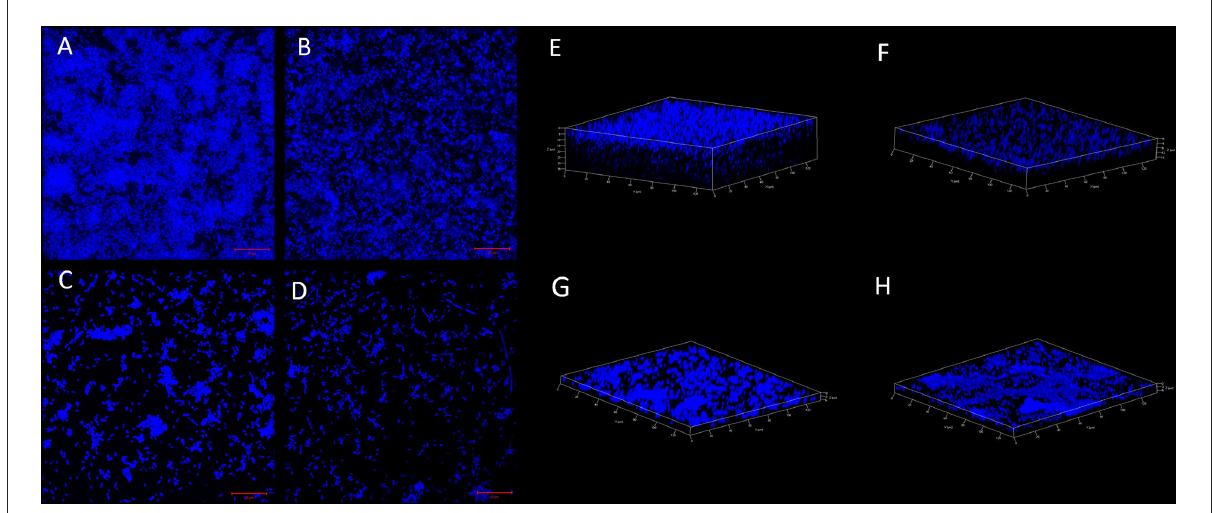
FIGURE5 (A–D) Biofilm cell adherence assay through CSLM. (A,B) show control EcN and K12 cells while the (C,D) show csgD -KD cells of EcN and K12. The control cells (A,B ) robust biofilm and aggregated cells have high EPS content, while the csgD -KD cells show a reduction in the EPS contents, as well, as the cells seem to be dispersed. The images were taken on a 20- µ m scale. (E–H) 3D confocal images are showing biofilm thickness. (E,F) show control EcN and K12 cells, while G,H show csgD -KD cells of EcN and K12. The csgD -KD cells show a reduction in the